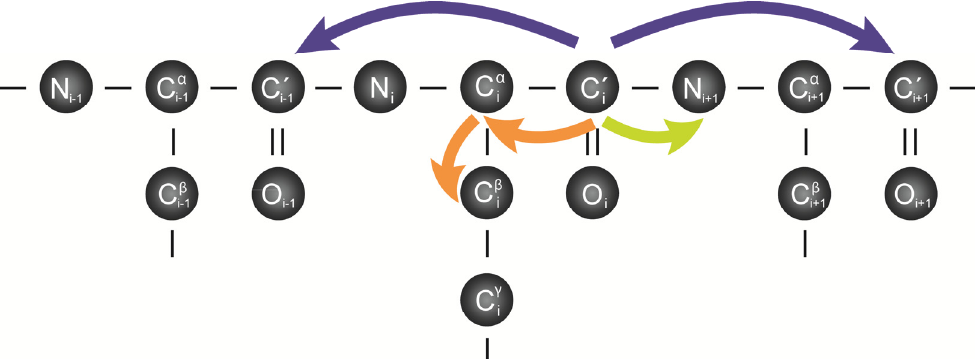
the detected correlations by using the following 13 C-direct detection NMR experiment type: 3D COCON experiment (purple), 3D CBCACON (orange) and 2D CON